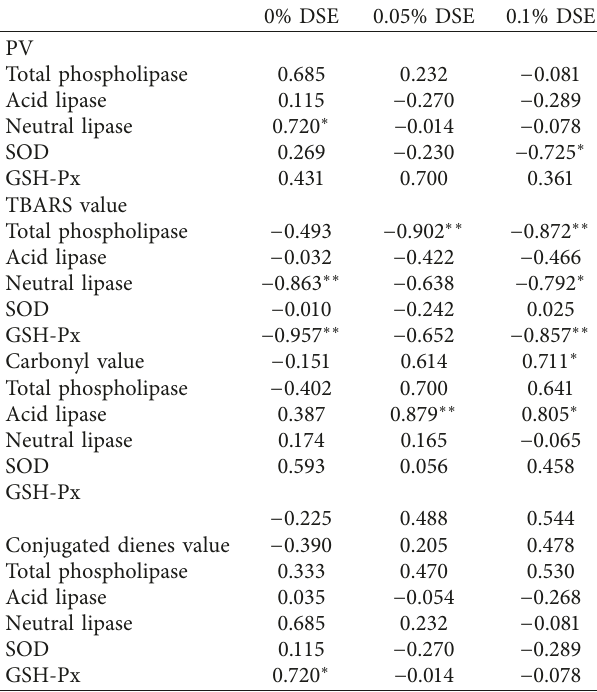
Table 3: Correlation of oxidation indices and total phospholipase, acid lipase, neutral lipase, and SOD and GSH-Px activities as processing time